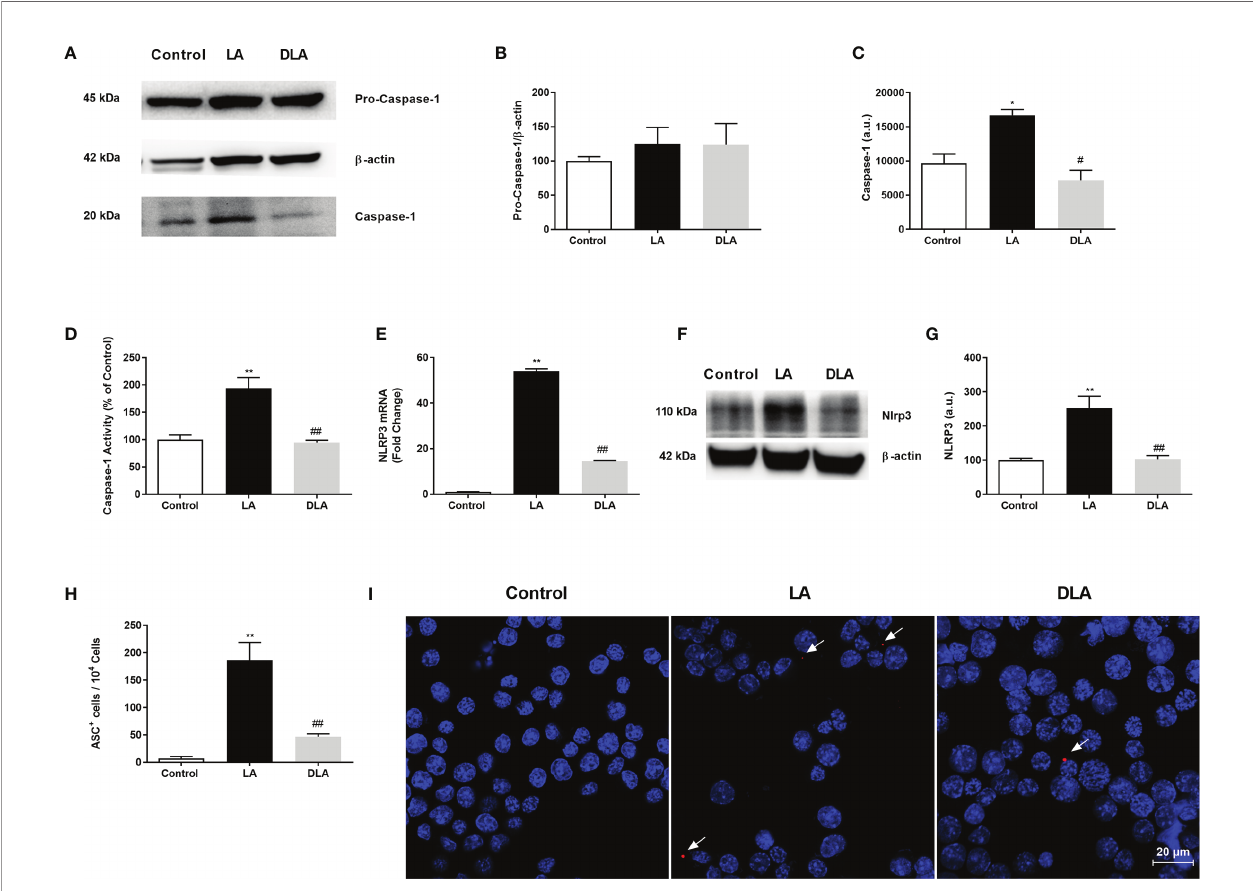
FIGURE 2 | DMF decreased the expression of in fl ammasome complex proteins, prevented caspase-1 activity and ASC speck formation. N9 microglia were pretreated with DMF (10 µM) for 1h, primed with UP-LPS (1000 ng/ml) for 4 hours, and followed by ATP (5 mM) for 1 hour. Pretreatment with DMF led to decrease expression of NLRP3, inhibited cleavage of pro-caspase 1(p45) into caspase-1(p20), and prevented caspase-1 activity and ASC speck formation in microglia. (A – C) The expression of pro-caspase-1 and its cleavage were evaluated with Western blot. (D) Caspase-1 activity was measured with a luminometric assay. (E) mRNA expression of NLRP3 was measured with qRT-PCR. (F, G) . Protein expression of NLRP3 was detected by Western blot. (H, I) ASC speck formation was demonstrated by the IF method (Blue staining – Hoechst, Red staining – ASC). Data are presented as mean ± S.E.M, n = 5. *p < 0.05, **p < 0.01 compared to control and # p < 0.05, ## p < 0.01 compared to LPS and ATP induced